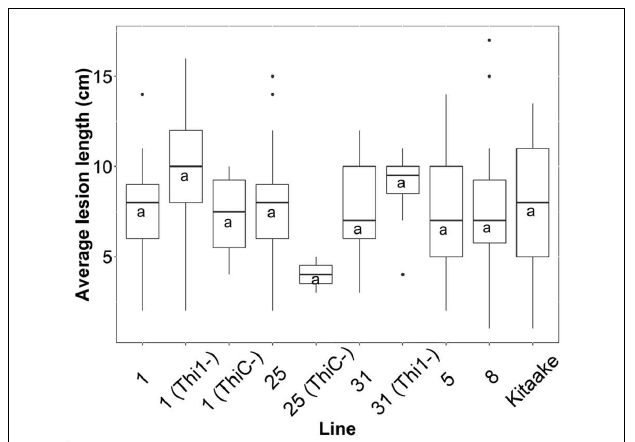
FIGURE 8 | Average lesion lengths from F 2 progeny derived from five THI1 × THIC lines infected with X. oryzae pv. oryzae . Lesion lengths were measured 2 weeks after X. oryzae pv. oryzae inoculation (strain PXO99A). F 2 progeny derived from five F 1 lines were classified by PCR for the presence or absence of THI1 and THIC transgenes (Supplementary Figure 1F). On the x-axis, ‘Kitaake’ represents 25 lesion measurements from six individuals. ‘1’ represents 21 lesion measurements from five F 2 progeny derived from F 1 line #1 that carry both THI1 and THIC . ‘1(Thi1-)’ represents 25 measurements from six F 2 progeny derived from F 1 line #1 that only carry THIC . ‘1(ThiC-)’ represents four measurements from one F 2 individual derived from F 1 line #1 that only carries THI1 . ‘25’ represents 34 measurements from eight F 2 progeny derived from F 1 line #25 that carry both THI1 and THIC . ‘25(ThiC-)’ represents two measurements from one F 2 individual derived from F 1 line #25 that only carries THI1 . ‘31’ represents 33 lesion measurements from seven progeny derived from F 1 line #31 that carry both THI1 and THIC . ‘31(Thi1-)’ represents eight measurements from two F 2 progeny derived from F 1 line #31 that only carry THIC . ‘5’ represents 49 lesion measurements from ten F 2 progeny derived from F 1 line #5 that carry both THI1 and THIC . ‘8’ represents 20 lesion measurements from four progeny derived from F 1 line #8 that carry both THI1 and THIC . The letter “a” indicates statistical grouping determined by Tukey–Kramer HSD analysis (alpha =